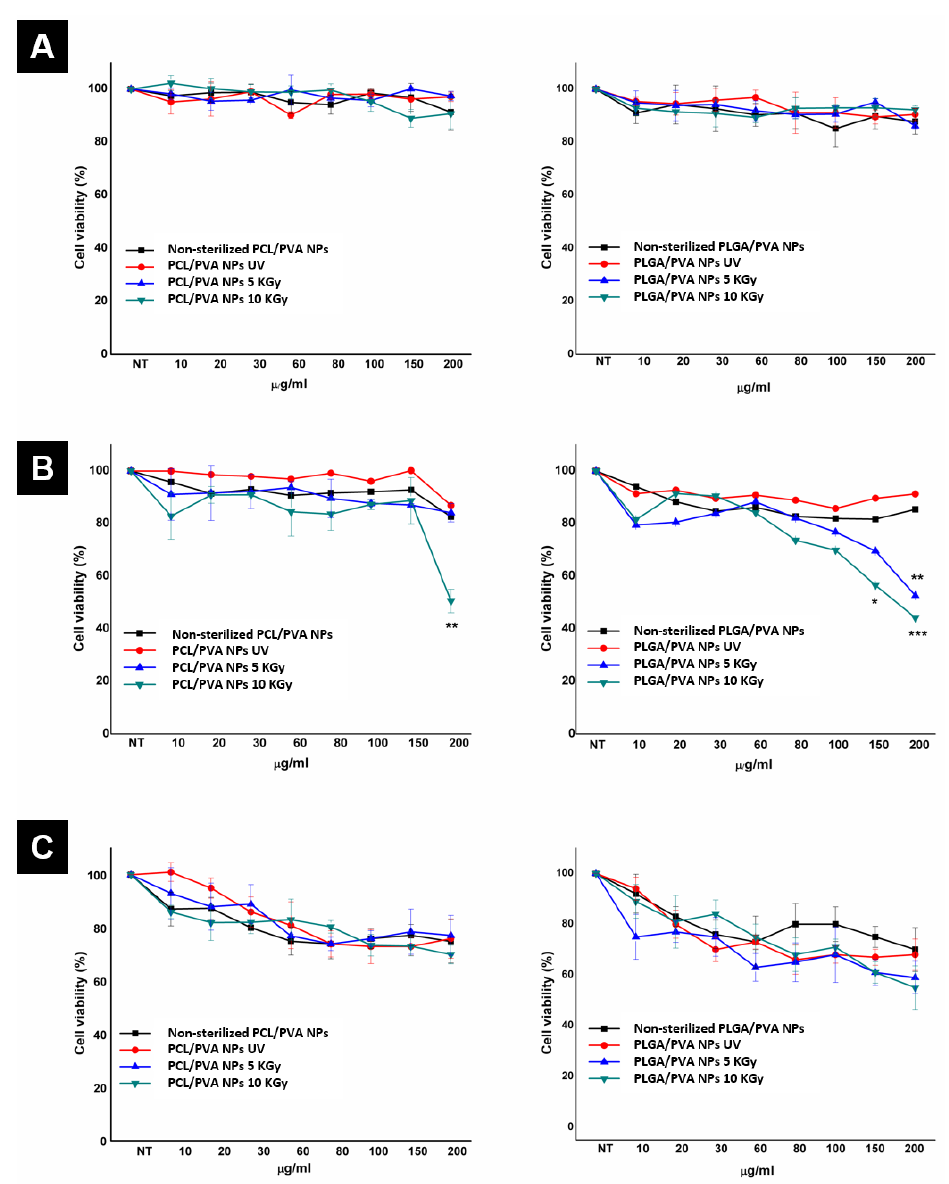
Figure 5. PCL / PVA NP and PLGA / PVA NP cell viability by MTT assay. Cells were treated for 24 h ( A ), 48 h ( B ), and 72 h ( C ) with 10-200 µ g / mL of PCL / PVA NP and PLGA / PVA NP, respectively. UV irradiation (red lines), 5 KGy (blue lines) and 10KGy (green lines) gamma irradiation were compared with non-sterilized NP (black lines). Untreated cells were considered as a value of 100% viability. The results are expressed as the mean ± SD of three separate experiments. * P ≤ 0.1, ** P ≤ 0.01, and *** P ≤ 0.001 compared with non-treated cells (control).